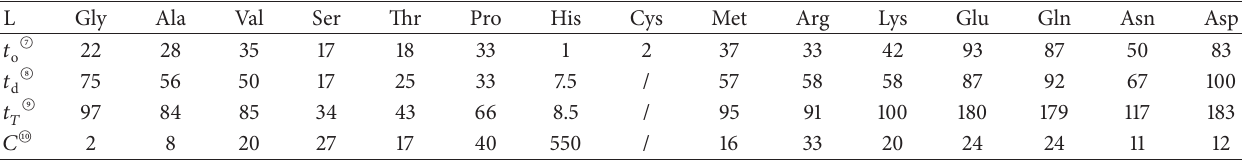
Table 3: Oxygenation parameters of 15 amino acid